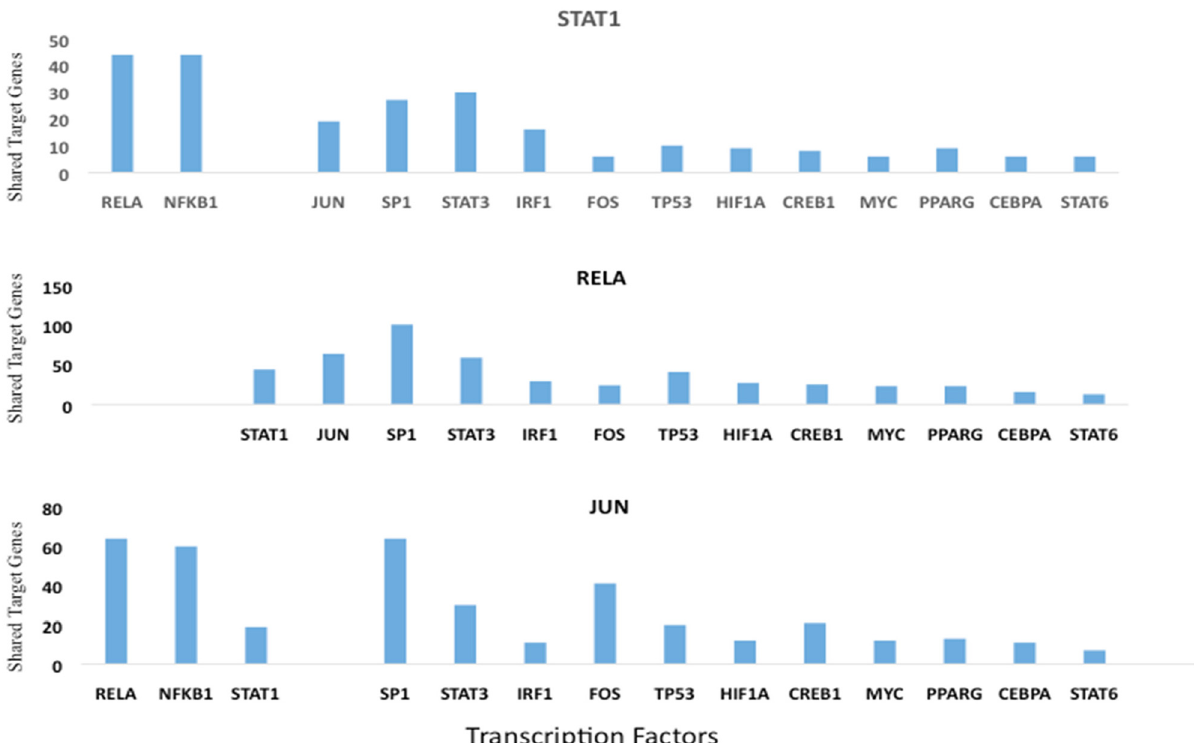
Figure 3: Shared transcription factor pro fi les in the target genes of STAT1, RELA, and JUN. Data retrieved from TRRUST transcription factor database [ 18 ]